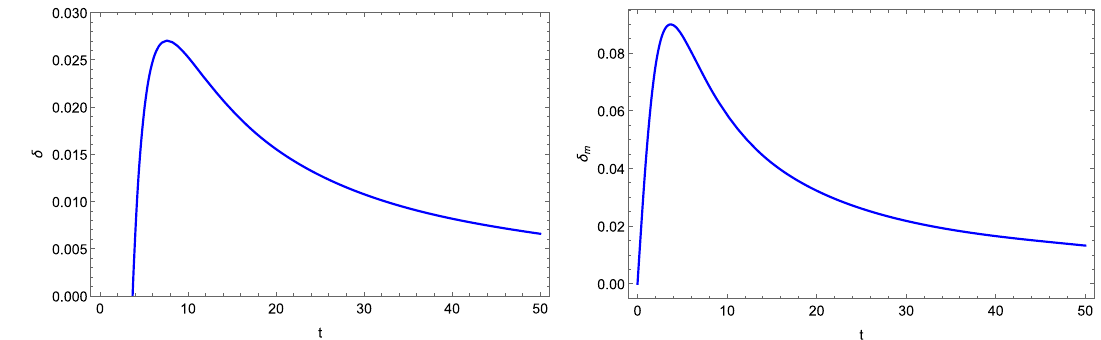
Fig. 4 Evolution of Hubble parameter and the energy density in cosmic time for C 1 = 1 and C 2 = − 1 / 3 (matter dominated